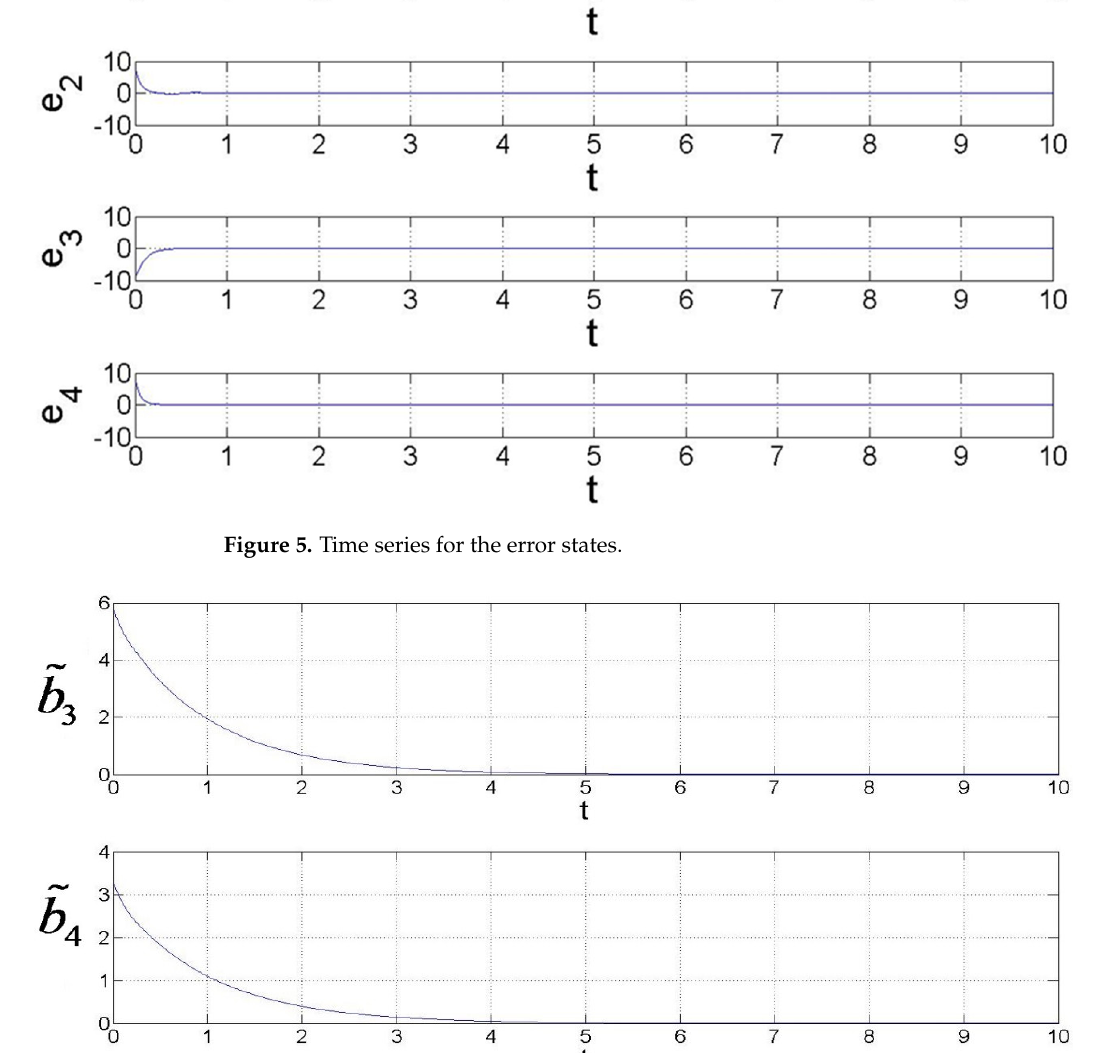
Figure 6. Time series for the error of parameters.